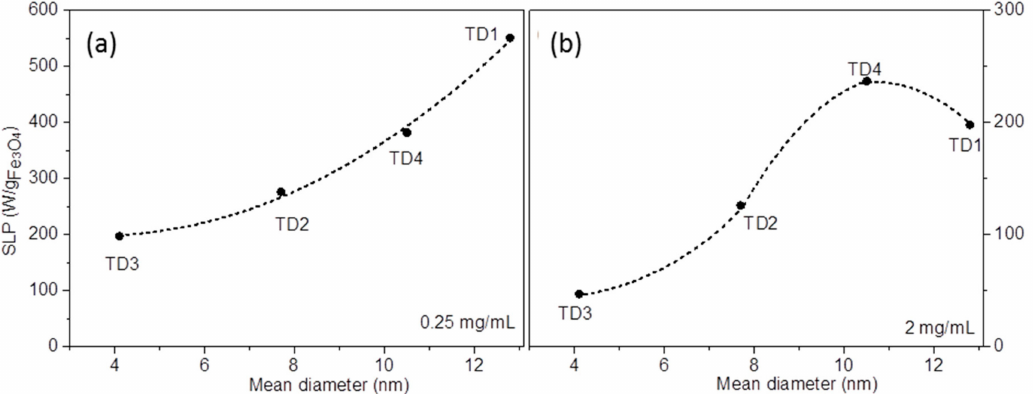
Figure 11. SLP values versus mean diameter of nanoparticles. The graphs refer to measurements that were carried out at concentrations ( a ) 0.25 mg / mL and ( b ) 2 mg / mL. At 0.25 mg / mL the graph is parabolic, while at 2 mg / mL a maximum value appears for TD4 (10.5